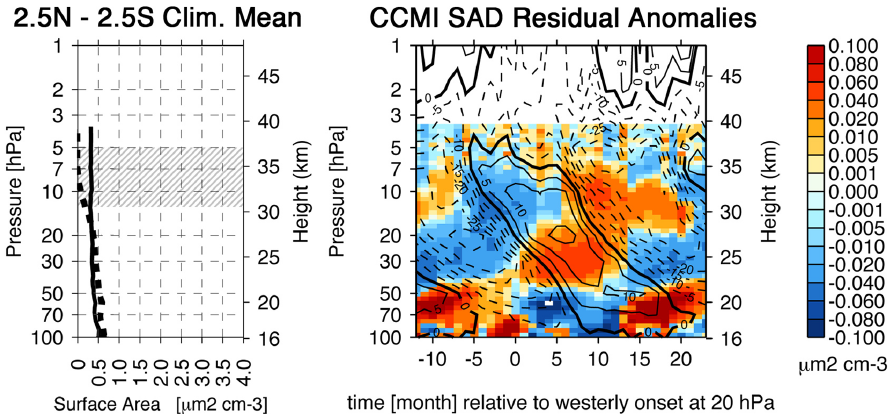
Figure 8. As in Fig. 6, except for the SAD climatology between 2.5 ◦ N and 2.5 ◦ S of the SPARC CCMI initiative, inferred from space- borne SAGE II and CALIOP observations. The profile in (a) is complemented by the climatological averaged SAD of the SPARC CCMVal initiative. The overlaid zonal wind in (b) is obtained from the ECMWF ERA-Interim climatology as in Fig.